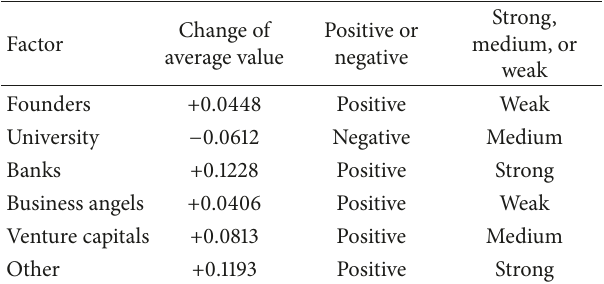
Table 1: Contribution results of different